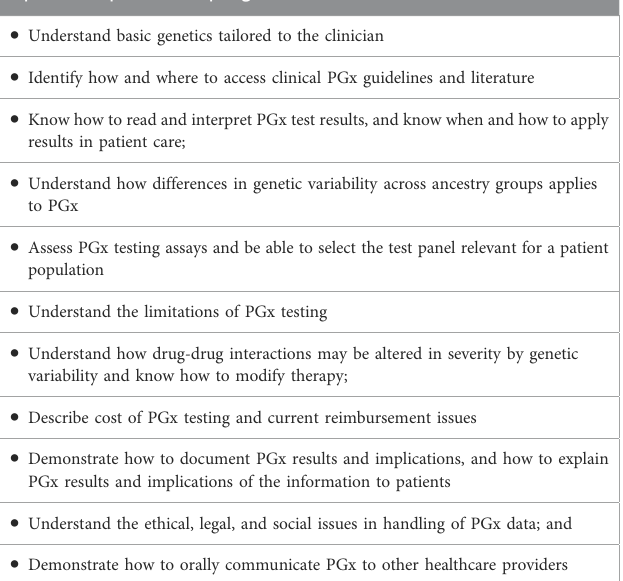
TABLE 1 Learning objectives of the University of Minnesota PGx workforce educational program. Upon completion of program, trainees are able to